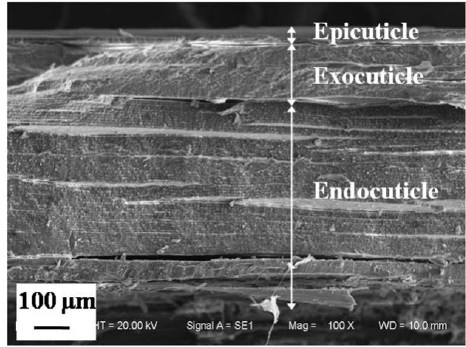
Figure 7. Layered structure in longitudinal section of dactylopodite.